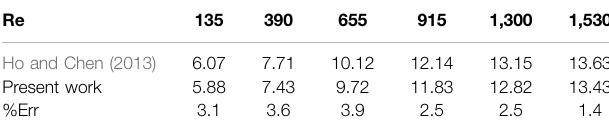
TABLE 2 | Average Nusselt number along the channel for the present work and Ho and Chen (2013).